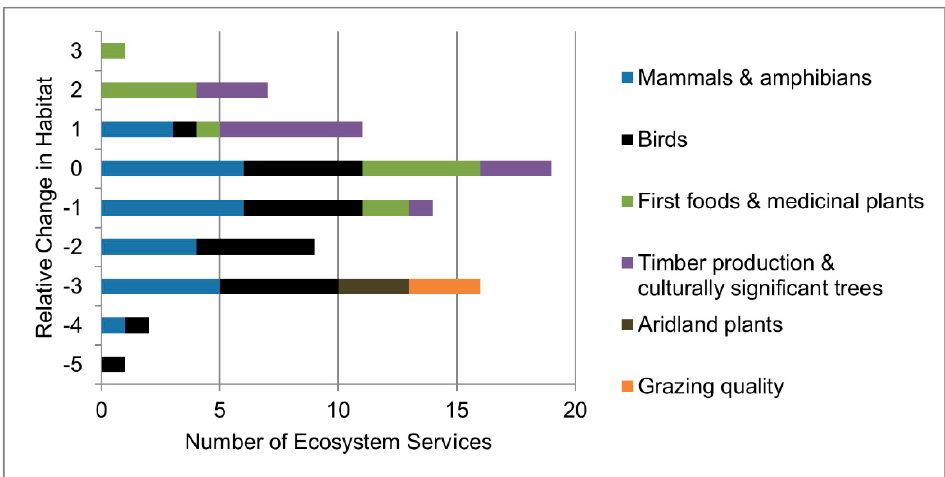
Figure 6. The number of ecosystem services and their relative change in potential habitat as calculated by converting the difference between the historical and the future average to a relative directional change for six categories of ecosystem services by the end of the century (2070–2099) under RCP 8.5. Negative numbers of relative change indicate a loss of potential habitat, whereas positive numbers indicate a increase of potential habitat.